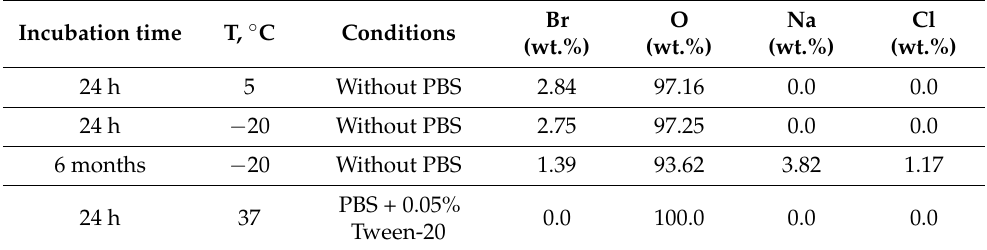
Table 1. Elemental composition of PCL Ilo/CAD TEVGs.